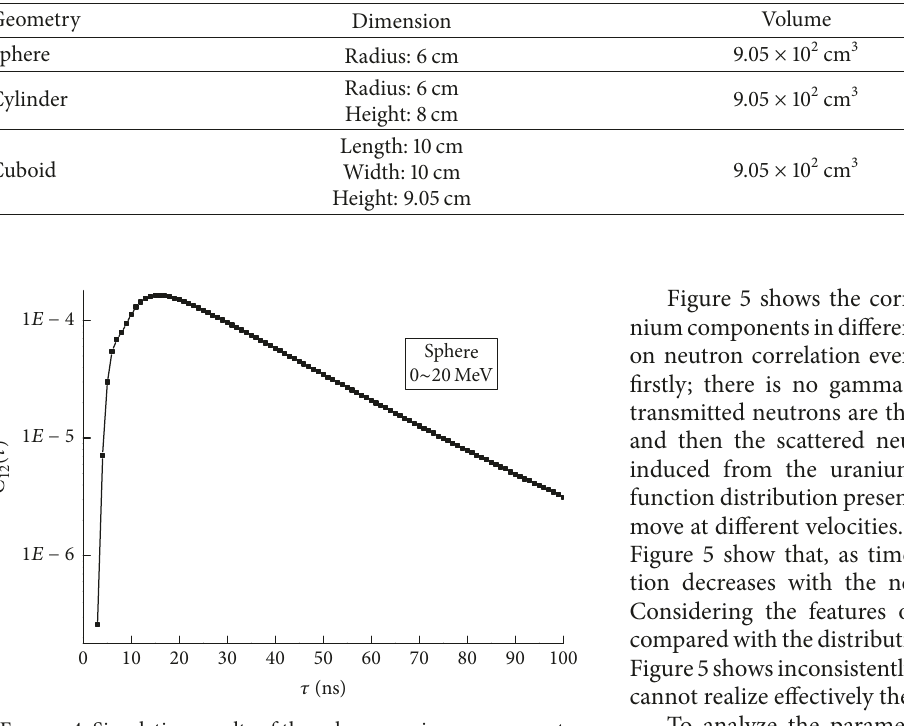
Figure 4: Simulation results of the sphere uranium component.